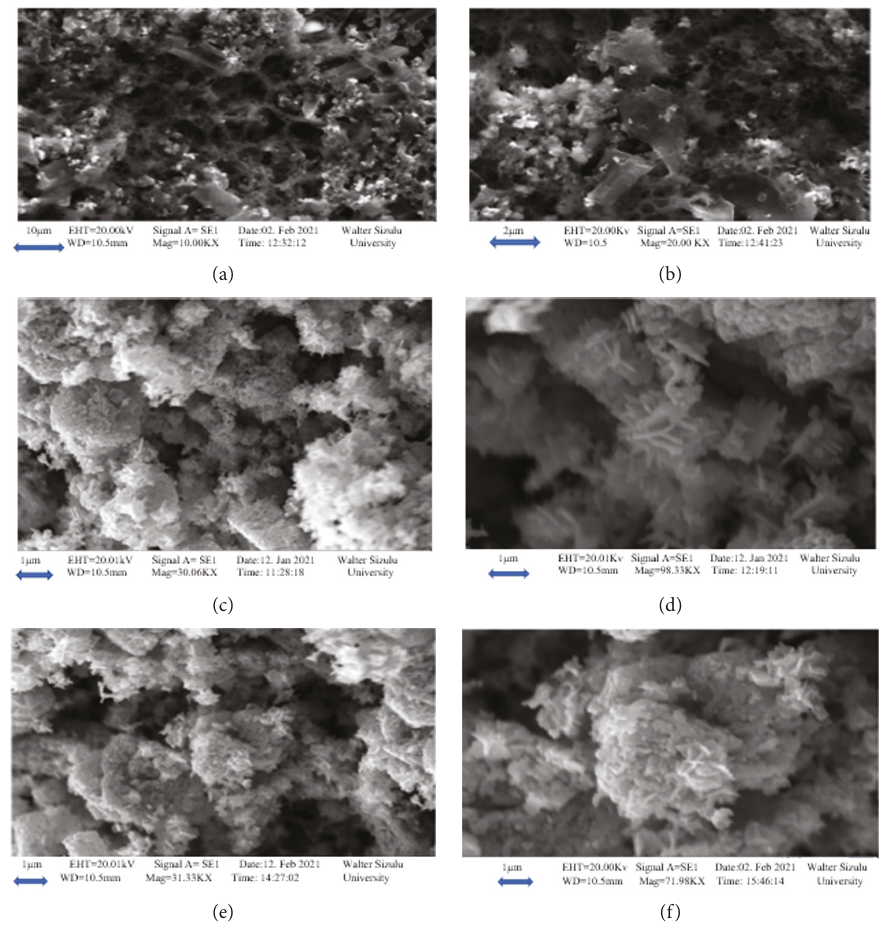
Figure 8: Scanning electron microscopy image of ZnO nanoparticles at different resolutions (a, b), as well as at different magnifications (c-f). Table 2: Standard data of hexagonal ZnO from JCPDS (A) and recorded data of the synthesized ZnO nanoparticles from this experiment